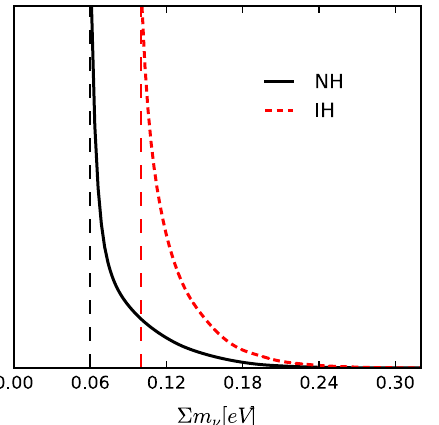
(cid:2) Fig. 3 The likelihood distributions of m ν for the NH and IH neu- trinos in the ν(cid:2) CDM model. The dashed lines donate the allowed min- (cid:2) m ν , namely 0.059eV for NH and 0.101eV for IH imums of